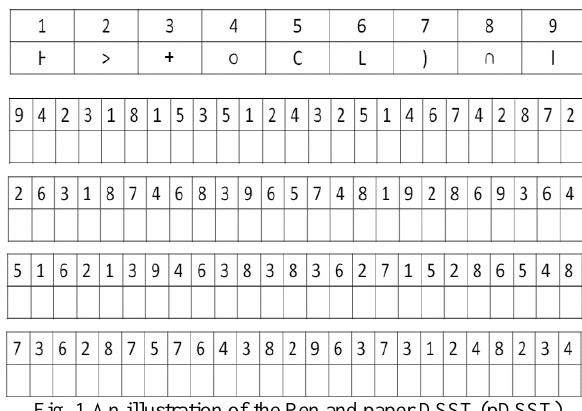
Fig. 1 An illustration of the Pen and paper DSST